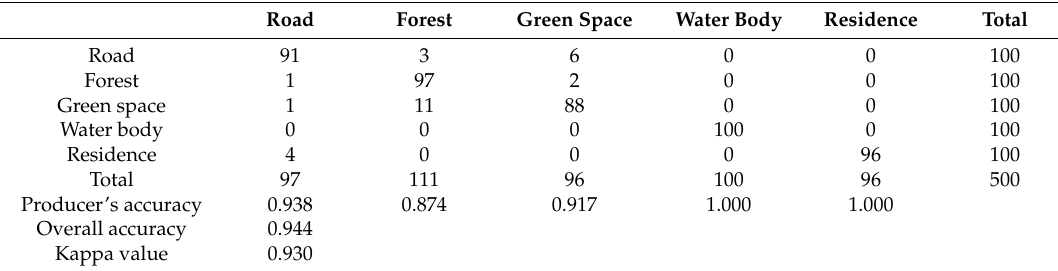
Table 2. The confusion matrix of the CAE_CNN model.